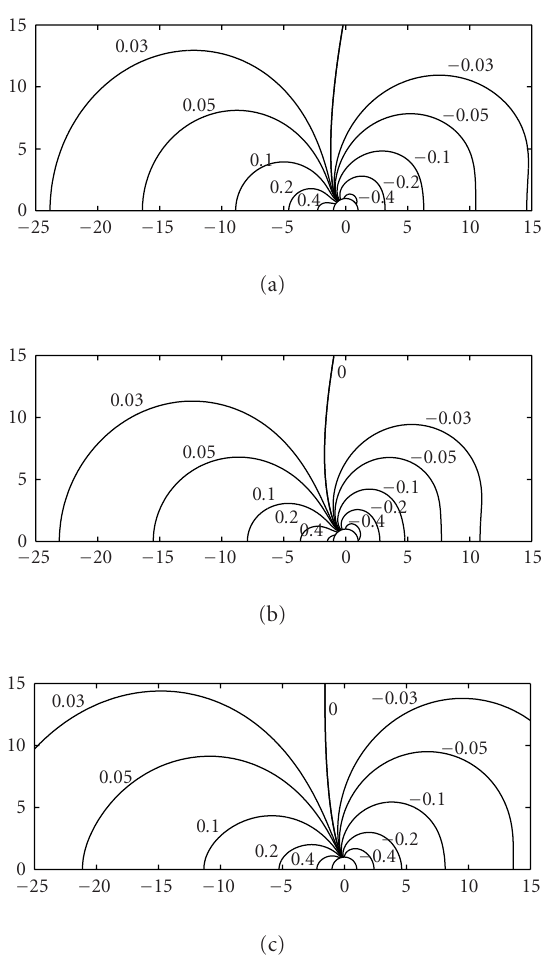
Figure 4.9 . Pressure fields for the flow with Re = 10. (a) N = 0, (b) N = 1, and (c) N = 15. the sphere when the magnetic field is increased. The pressure Poisson equation (2.8) is solved and the isocontours of pressure fields around the cylinder in presence of magnetic field for Re = 10,20, and 40 are presented in Figures 4.9, 4.10, and 4.11, respectively. From these figures, it is evident that the pressure in the downstream region is reduced up to a certain value of N and then increases in both upstream and downstream regions with fur- ther increase in the magnetic field. This behavior can be attributed to the nonmonotonic behavior in separation length and separation point. For the case of flow past a circu- lar cylinder, Fornberg [7] has presented the pressure fields for Re = 100–600. The radial and transverse velocity components at θ = 90 ◦ (interface of upstream and downstream regions) are given in Figure 4.12 for Re =